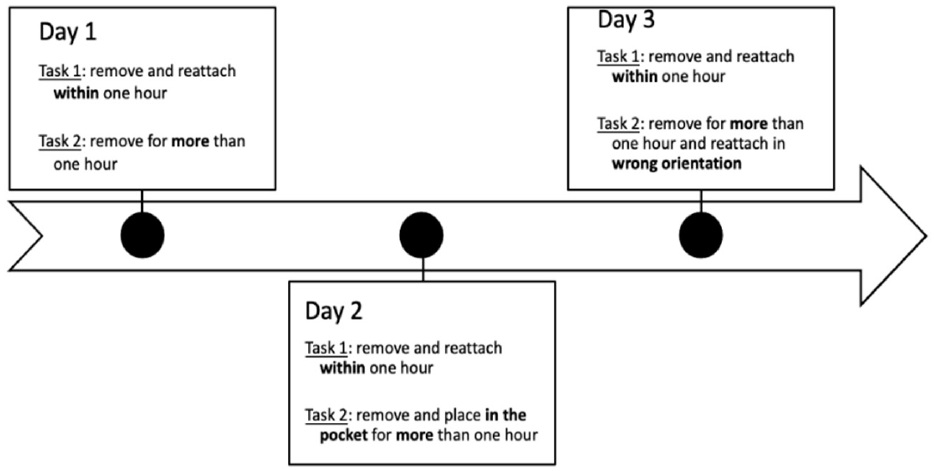
Figure 1. Summary of the tasks included in the data acquisition protocol. The participants were instructed to remove the device twice a day. Task 1 was per- formed each day and consisted of removing the device for less than an hour to test the ability of the algorithms to detect short non-wear periods, which are usually ignored by many state-of-the-art methods. The second task was different each day and consisted of removing the device for more than one hour (day 1), removing and placing the device in a pocket (day 2), and removing and reattaching the device in the wrong orientation (day 3) as indicated in Figure 1. The participants were asked to perform three claps with the sensor upon removal of the device as well as prior to reattachment to allow for comparison between diary entry times and device